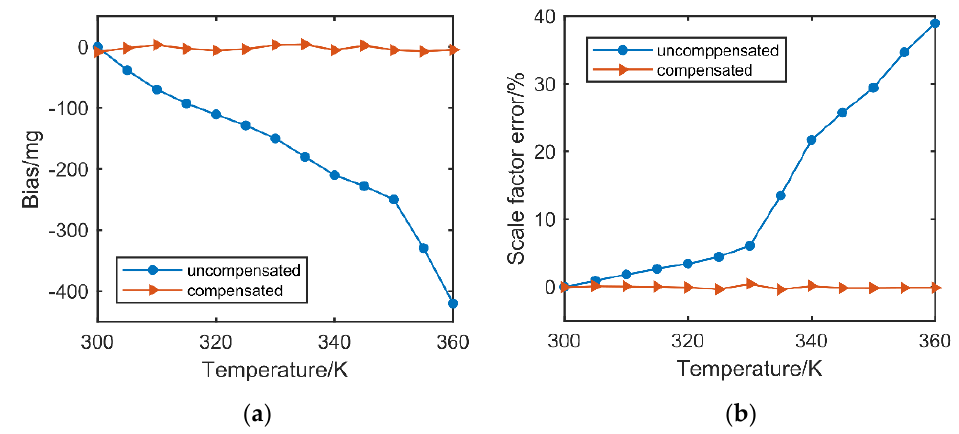
Figure 8. ( a ) Comparation on bias drifts of acceleration before and after compensation. ( b ) Comparation on errors of scale factor before and after compensation.